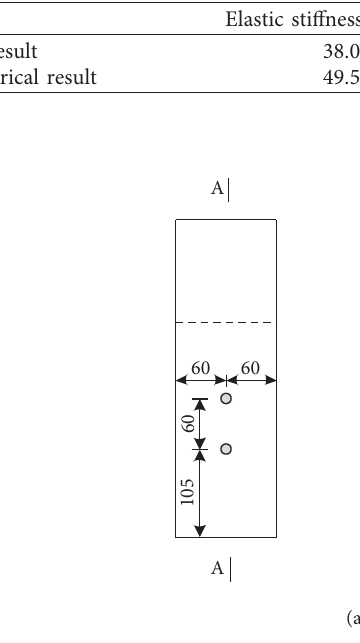
Figure 10: Two bolted glulam joints considered in the parametric study. (a) Joint 1. (b) Joint 2.